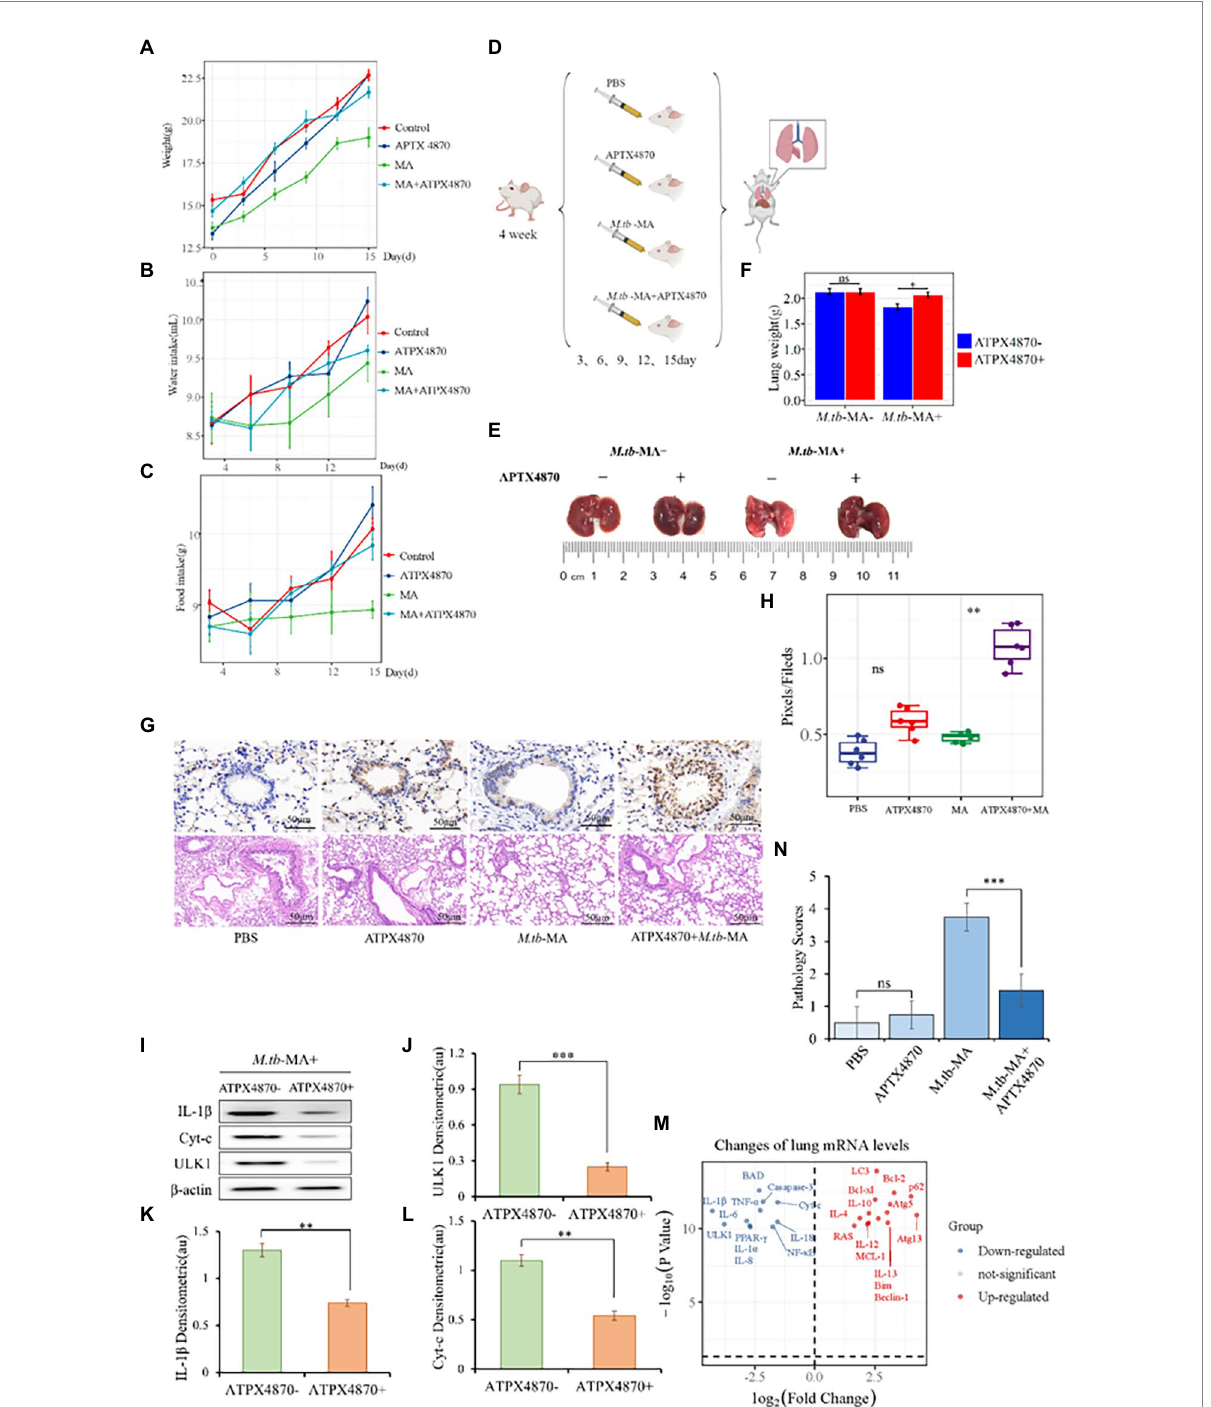
FIGURE 3 APTX4870 inhibits M.tb -MA induced cell injury in vivo . (A–C) The measurement of weight, food intake, and drinking water of mice in different treatment groups ( n = 6). Body weights of mice were measured on days 0, 3, 6, 9, 12, and 15. Food consumption in mice was measured on days 3, 6, 9, 12, and 15. Following the placement of 50 g of feed on the 0th day, the food intake of the mice was estimated on the 3rd day by weighing the decreased grams of feed, and so on. The procedure for measuring mice’s water consumption is the same as for eating. (D) Treatment scheme for different groups. (E,F) Representative images of mice lung tissue and weight. The data were shown as means ± SD ( n = 6). (G,H) Immunohistochemical (IHC) analysis of IL-1 β , Hematoxylin, and eosin (H&E) staining of the lungs. Scale bars, 50 μ m. Quantitative the expression of IL-1 β by optical densitometry assay using ImageJ Software version 1.46. The data were shown as means ± SD and compared by a 2-way ANOVA test. ** 0.01 < p < 0.05: APTX4870 + M.tb -MA vs. M.tb -MA ( n = 6; I–L ). Representative immunoblots of IL-1 β , ULK1, and Cyt-c in mice lungs from three repeated experiments. Semi-quantitative expression of indicated proteins by optical densitometry assay using ImageJ Software version 1.46. Data were presented as mean ± SD, ** 0.01 < p < 0.05; *** p < 0.001: APTX4870 + M.tb -MA vs. M.tb -MA ( n = 3). (M) Total RNA was extracted from lung tissue in order to assess gene expression. The result of the APTX4870 co-treated group vs. the M.tb -MA group was shown by Volcano. * p < 0.05, log2 Fold Change ≥ 2 ( n = 3). (N) The severity of per bronchial inflammation was graded quantitatively by the five-point scoring system ( n =